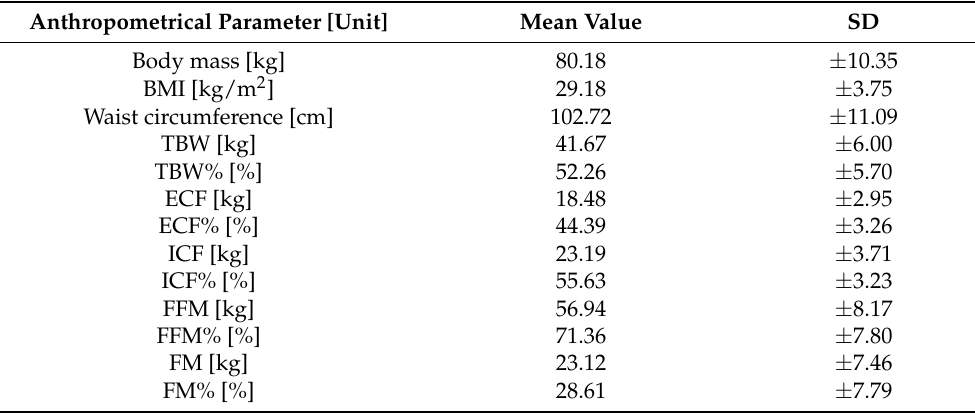
Table 1. Anthropometrical characteristics of the central obesity